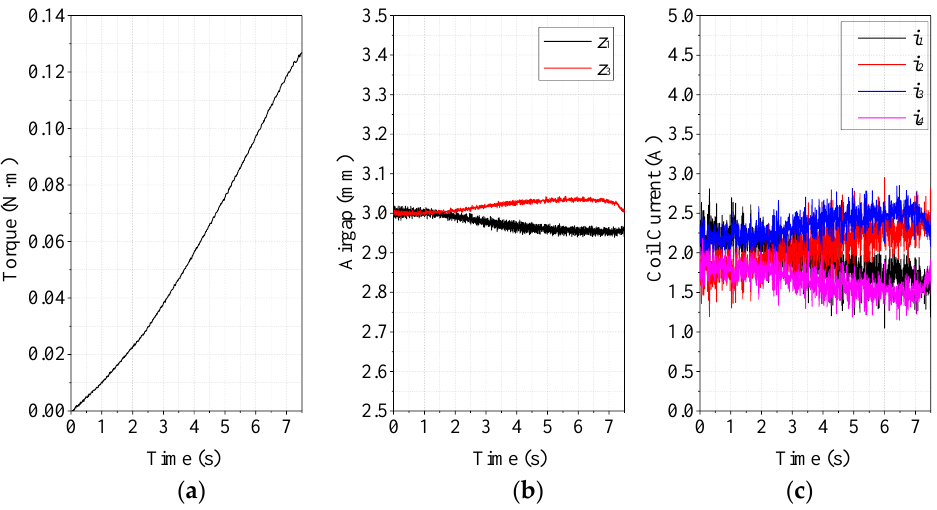
Figure 12. Experiment result: ( a ) Torque ( b ) Airgap response ( c ) Current response.